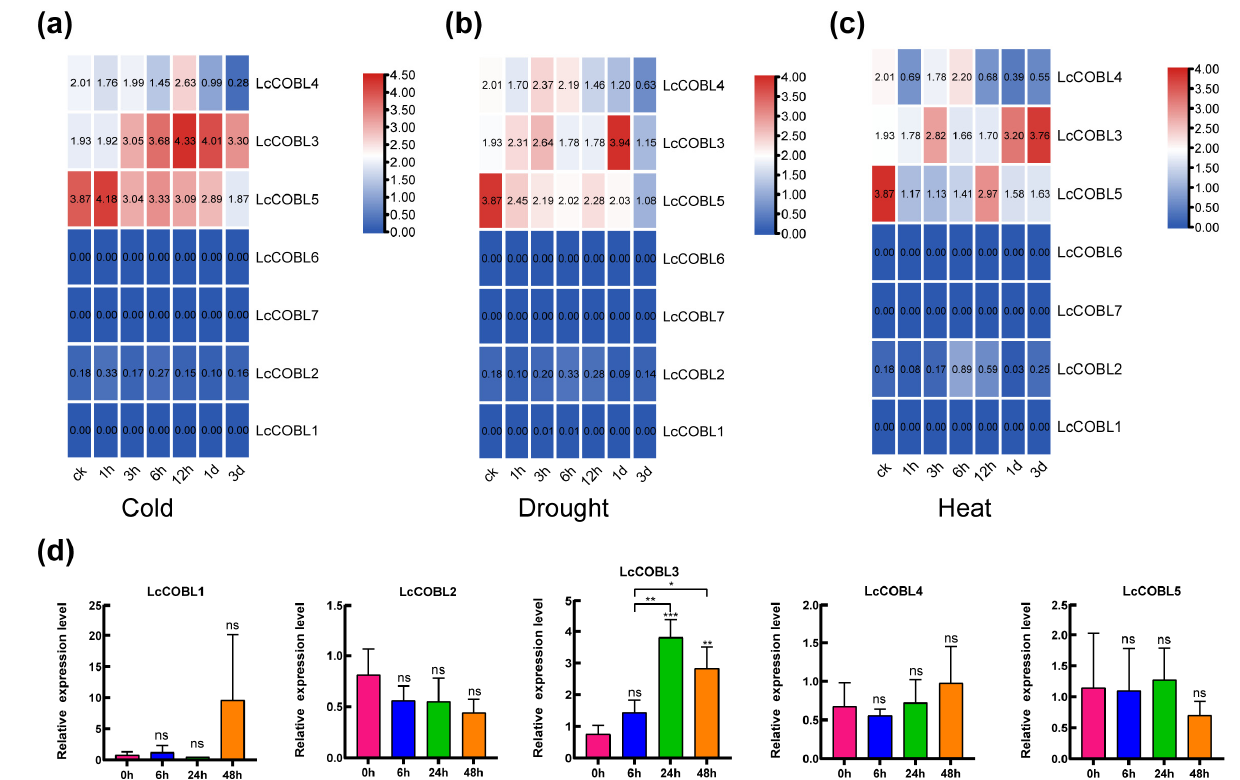
Figure 6. The expression patterns of LcCOBL genes in L. chinense under abiotic stresses. ( a – c ) Expression profiles of LcCOBL genes in L. chinense under biotic stresses, including cold ( a ), drought ( b ) and heat ( c ) stress. The heatmap data were averaged and plotted using TBtools, with red representing a high expression level and blue representing a low expression level; ( d ) qRT-PCR analysis of LcCOBL genes under cold abiotic stress. The expression levels of related genes were calculated with 2 − ∆∆ Ct using 0 h as control. Mean values ± SE are shown for the 3 replicates, and the levels of significance relative to the control are ns: no significant difference, *: 0.01 ≤ p < 0.05, **: 0.001 ≤ p < 0.01 and ***: p < 0.001.